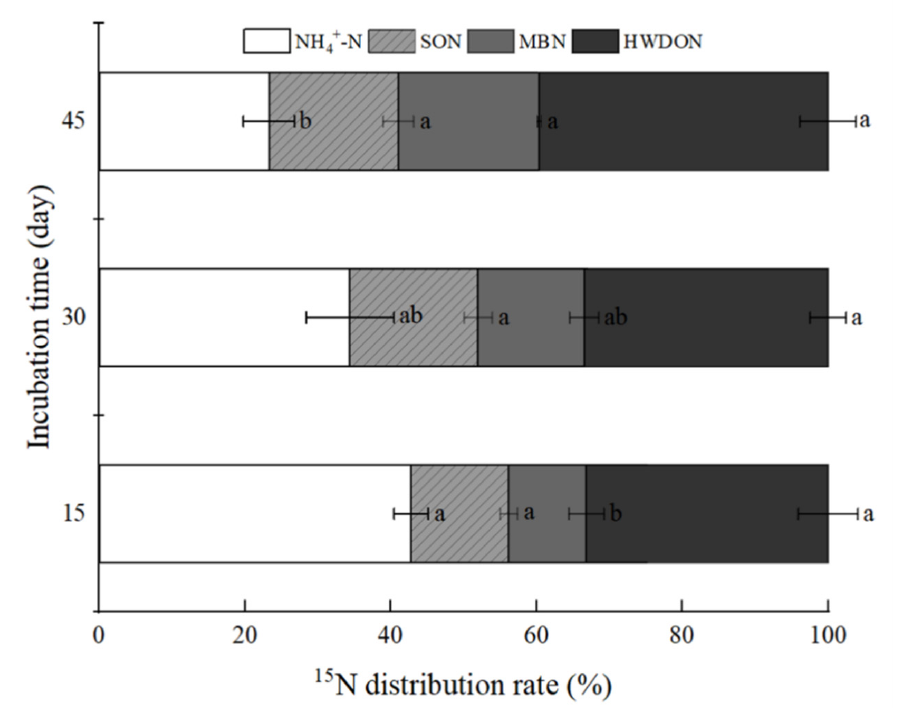
Figure 3. Exogenous nitrogen ( 15 N) distribution ratios of the available nitrogen fractions in the com- post (NO 3 − − N in all treatments was not shown here since all close to 0 and no significant difference among the treatments). SON, MBN, and HWDON indicate soil organic nitrogen, microbial biomass nitrogen, and hot-water extractable organic N, respectively. Different letters indicate significant differences in a certain N fraction content between different stages ( p < 0.05). Data were shown as the mean ± standard error ( n = 5). Table 2. Proportion of the available N fractions derived from exogenous N. On day 0, exogenous N was just added; it was regarded as no exogenous N having entered the available N fractions of the compost; SON, soluble organic nitrogen, MBN, and microbial biomass nitrogen; HWDON and hot- water extractable organic N.